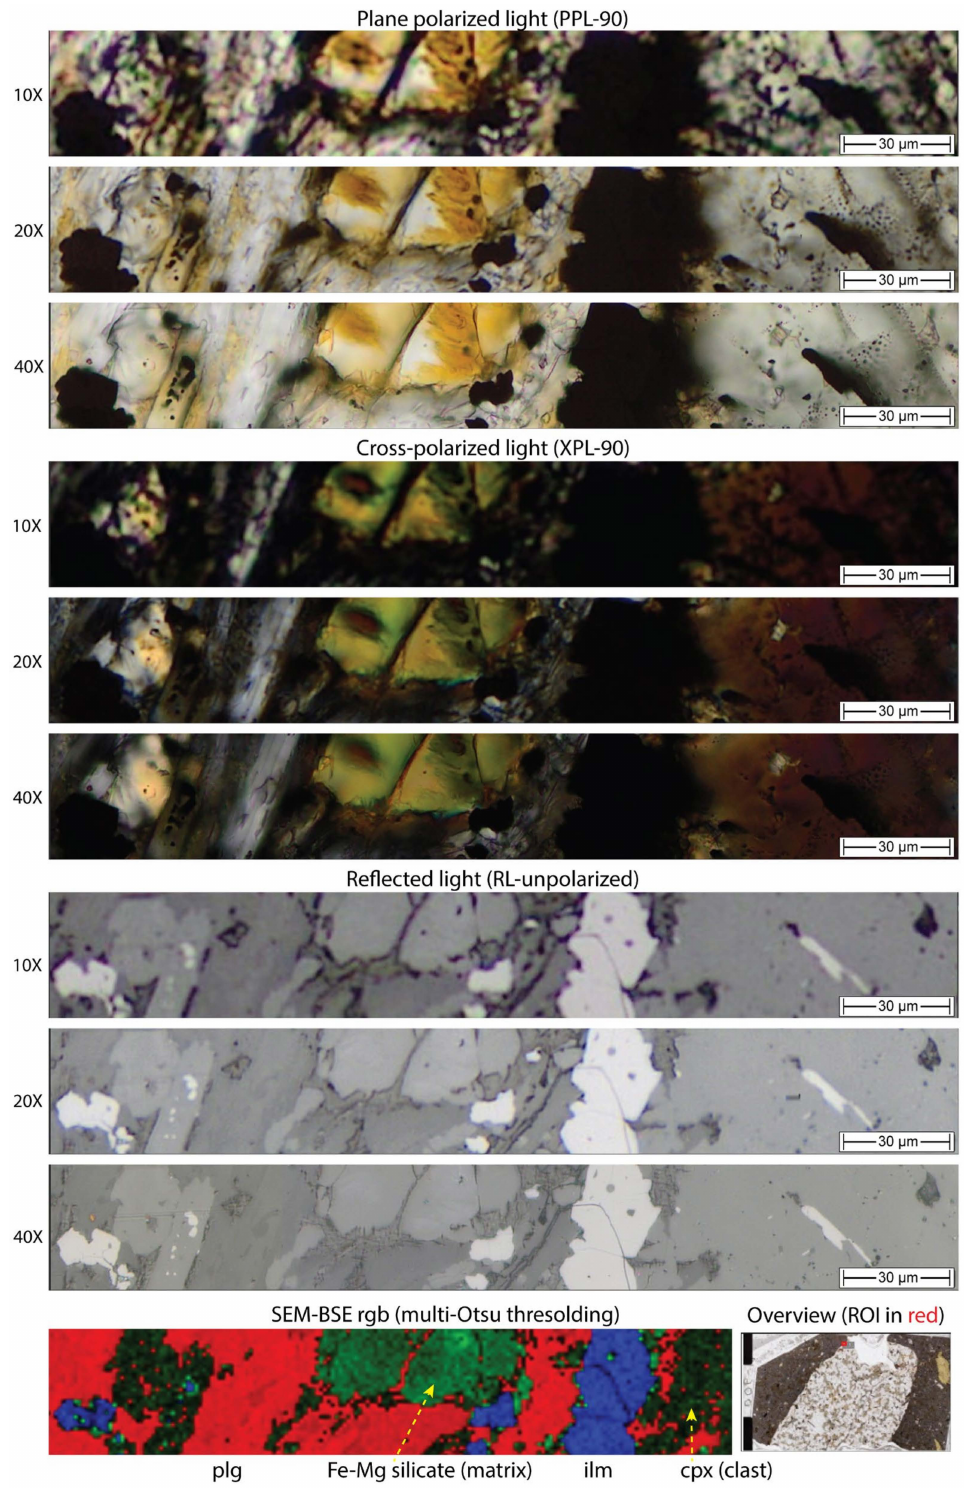
Figure 3. Example of VS200 optical performance in transmitted (PPL-90 and XPL-90) and reflected (RL unpolarised) light compared to a corresponding false-colour SEM-BSE image. From top to bottom (10 × : 0.547; 20 × : 0.273; 40 × : 0.137 µ m/px), the image shows a small area of a pyroxene-plagioclase granulite xenolith within a basalt (overview at bottom-right). In PPL, the decreasing depth-of-field at greater spatial resolutions is evident. In RL, the similarity of grain shapes is expected to be best in the recoloured SEM-BSE (Supplementary Materials for details). Sample 18-RBE-006h